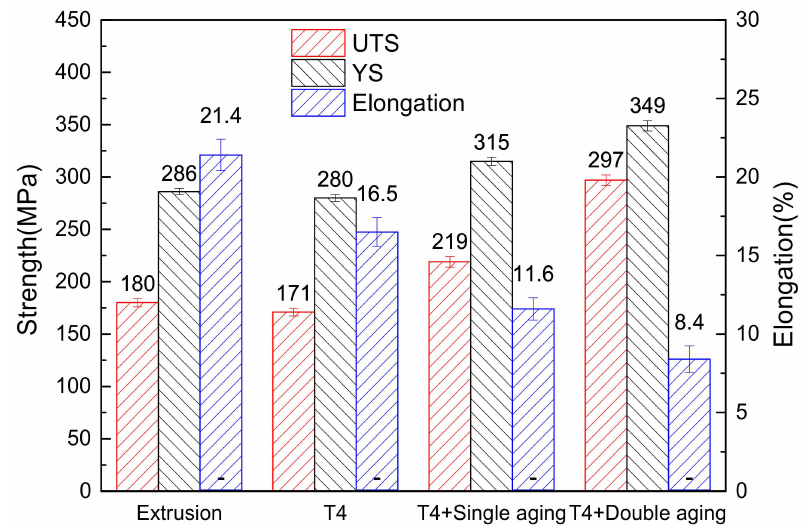
Figure 13. The mechanical properties of the ZM51 alloys in as-extruded, T4, single-aged, and double-aged conditions.